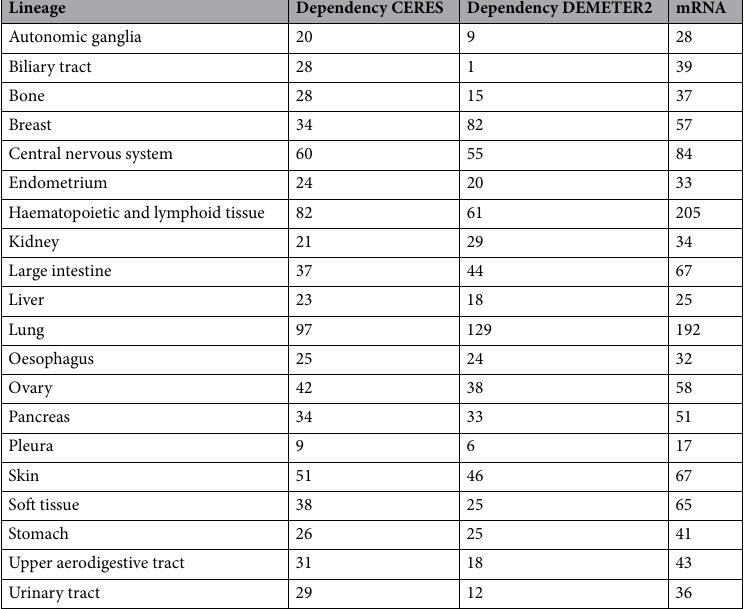
Table 1. Overview of tissue types and number of unique cell lines used for cell line genetic dependency analysis. 20 tissue types from the Cancer Dependency Map (DepMap) project with data for at least 25 cell lines were utilized for this